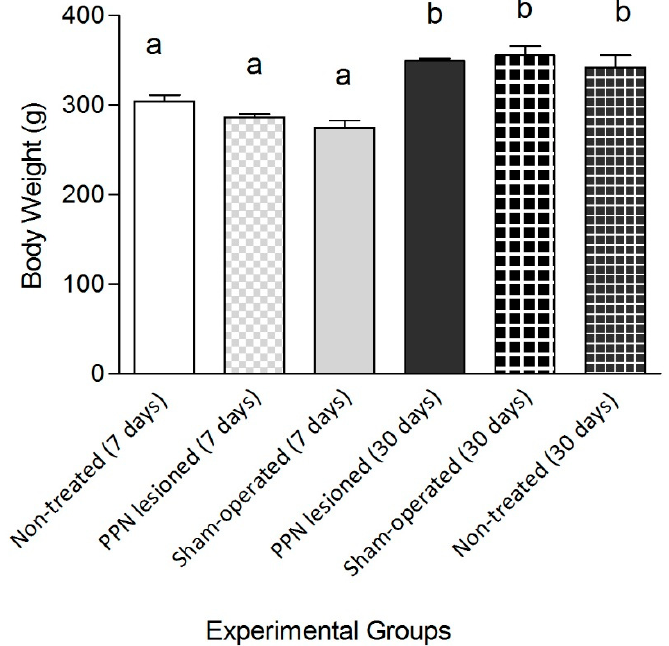
Figure 3. Comparative study of the body weight between experimental groups. The analysis of the body weight showed significant differences between experimental groups (F (5, 65) = 17.11 p ≤ 0.001). The body weight segregated the groups where the behavioral study was carried out seven and 30 days after pedunculopontine nucleus lesion. One-way ANOVA test. a vs. b: p < 0.01. The bars represent X ± E.E.M.